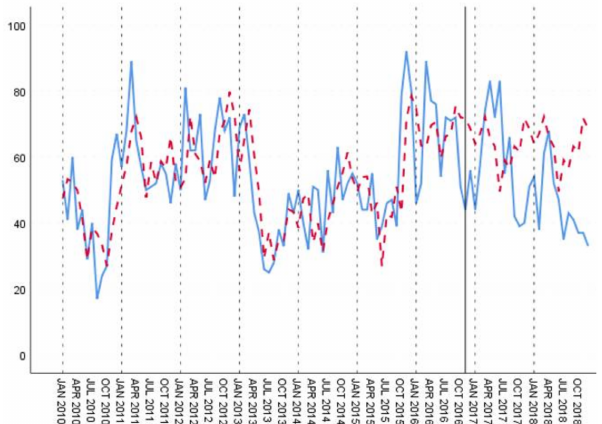
Figure 14. Fitting and prediction results for the time series model, group